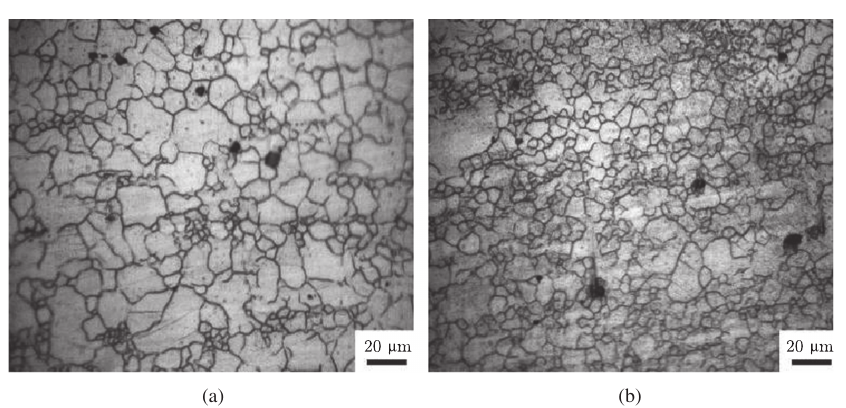
Figure 2: Microstructure of bars with different billet temperatures: (a) 370 ℃ , (b) 400 ℃ and (c) 420 ℃ .